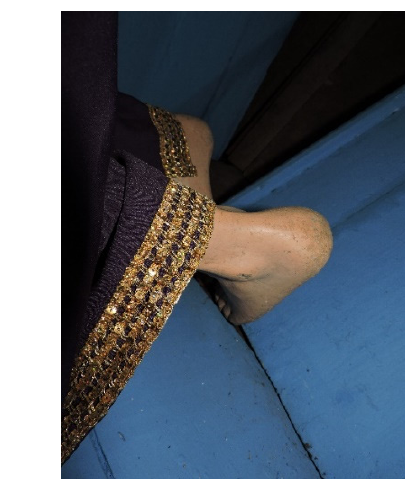
Figure 5. Detail of tied and folded hands. Photo by Lia Brusadin, 1 January 2017.